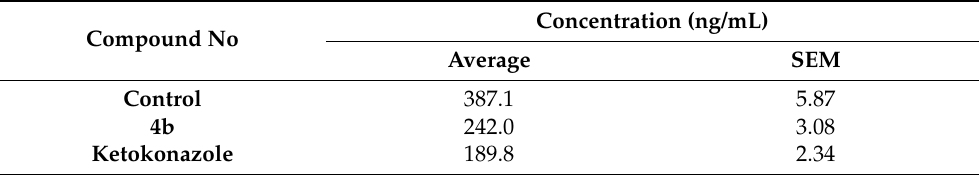
Table 6. Concentration of Pgp measured in ng/mL in MCF-7 breast cancer cells treated with 4b or